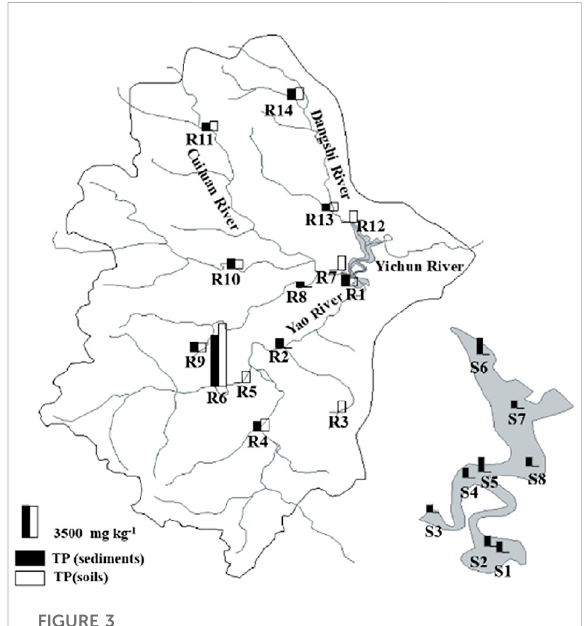
FIGURE 3 Spatial distribution characteristics of the TP content in soils and sediments of the Xishan Reservoir drainage area.